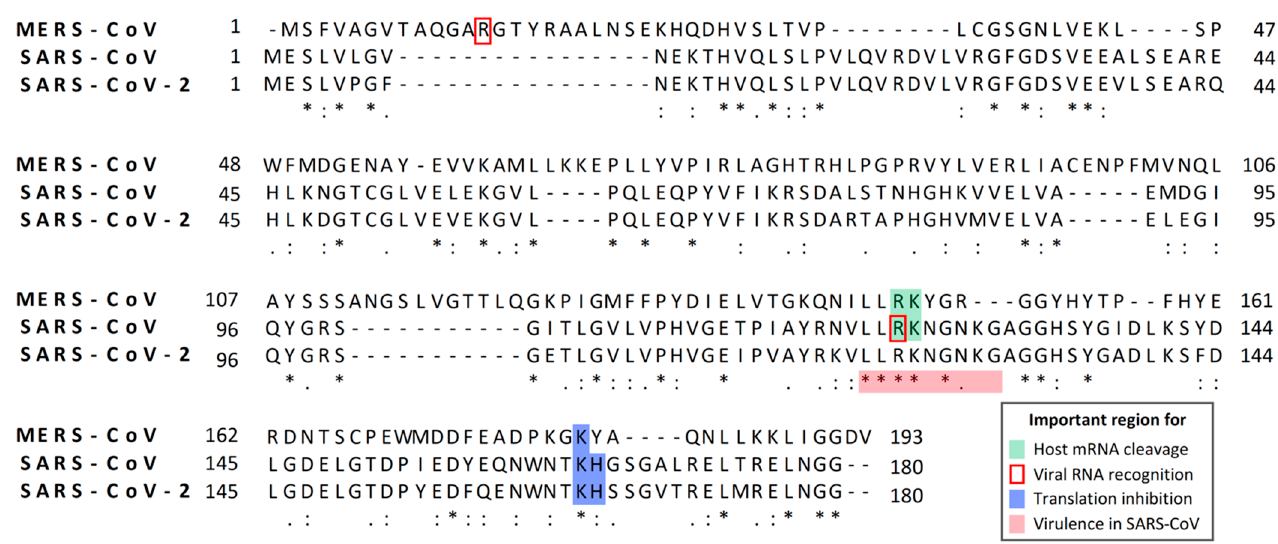
Figure 2. Alignment of the amino acid sequences of nsp1s of MERS-CoV, SARS-CoV, and SARS-CoV-2. Nsp1 sequences of the MERS-CoV strain EMC2012 (accession no.: YP_009047229), SARS-CoV strain Urbani (accession no.: AAP13442), and SARS-CoV-2 isolate Wuhan-Hu-1 (accession no.: MN908947.3) are aligned using Multiple Sequence Comparison by Log-Expectation (MUSCLE) alignment algorithm. Perfect matches, high-amino acid similarities, and low-amino acid similarities are represented by asterisks, double dots, and single dots, respectively. A dash “-” indicates a gap in the sequence. The numbers beside the aligned sequences show the positions of amino acid residues. Residues shown in green represent the functional amino acids for host mRNA cleavage. Residues shown by a red box outline represent the functional amino acids for viral mRNA recognition. Residues shown in blue represent the amino acids that are important for translation inhibition. Residues shown in red represent the amino acids that are important for virulence in mice.